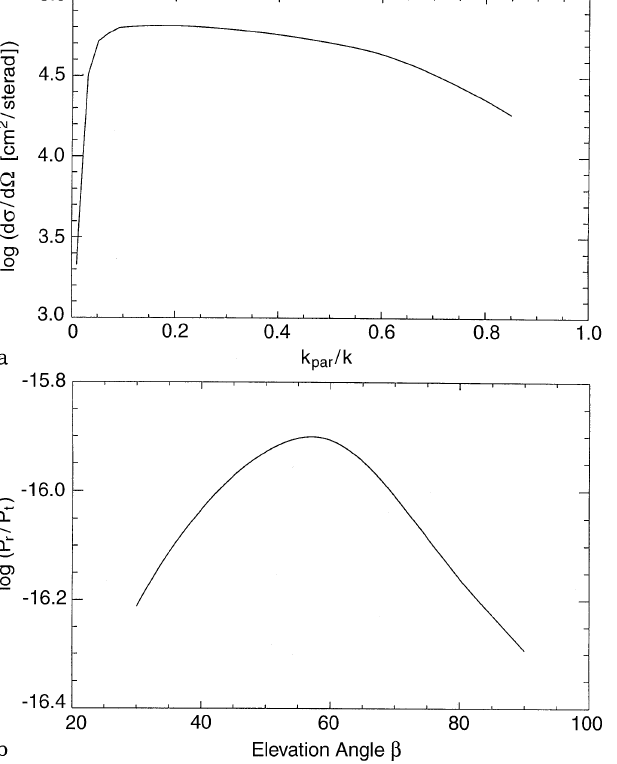
sin (cid:97) " k (cid:49)(cid:33)(cid:51) / k . The standard case, k (cid:49)(cid:33)(cid:51) / k " 0.01,